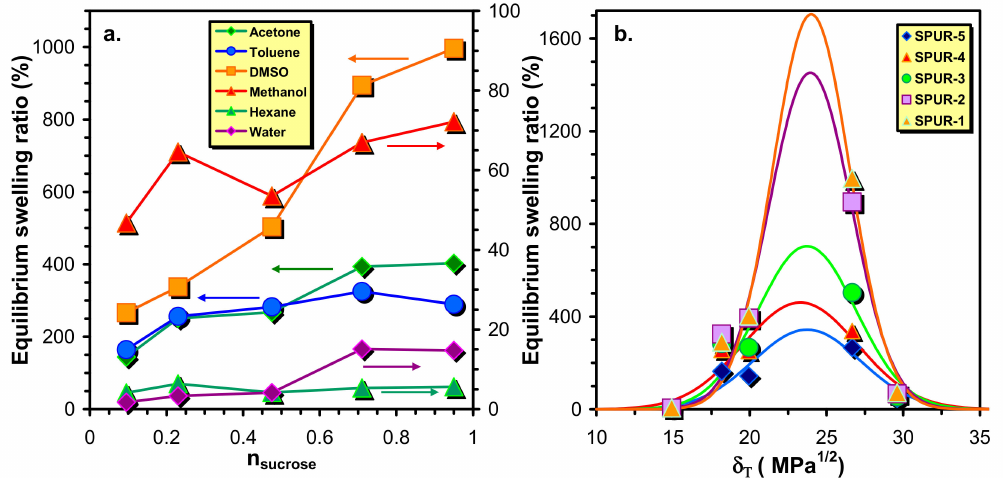
Figure 4. Variations of the swelling ratios with the molar ratios of sucrose ( a ) and the dependences of the swelling ratios on the values of the Hildebrand solubility parameter ( δ T ) ( b ). The solid lines in Figure 4b represent the fitted curves by Equation